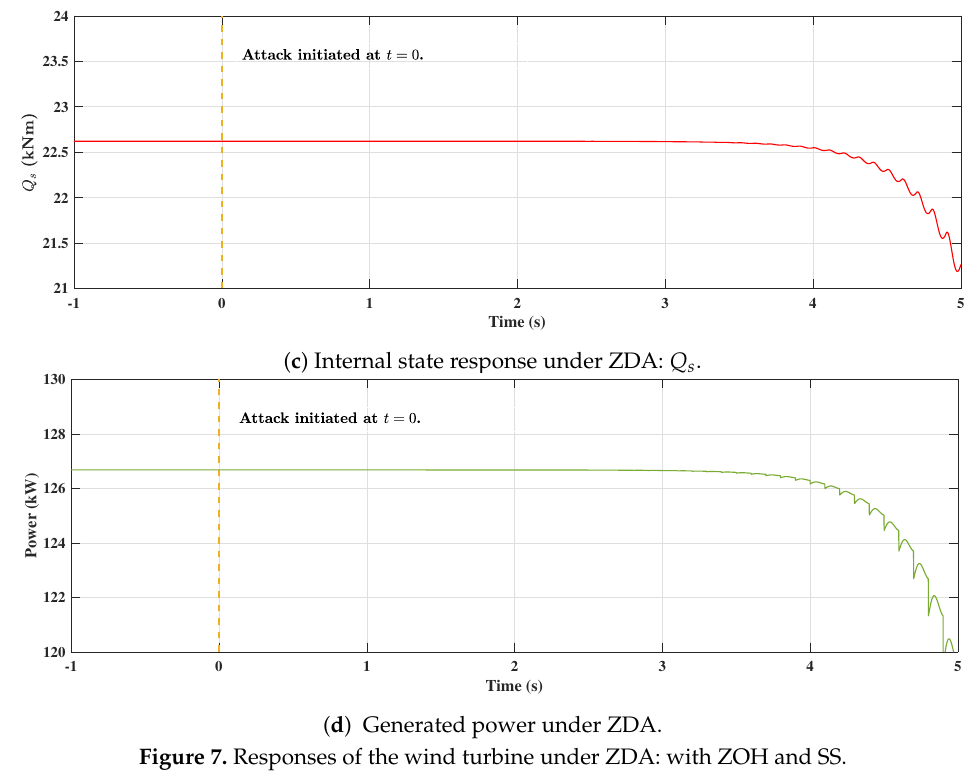
Figure 7. Responses of the wind turbine under ZDA: with ZOH and